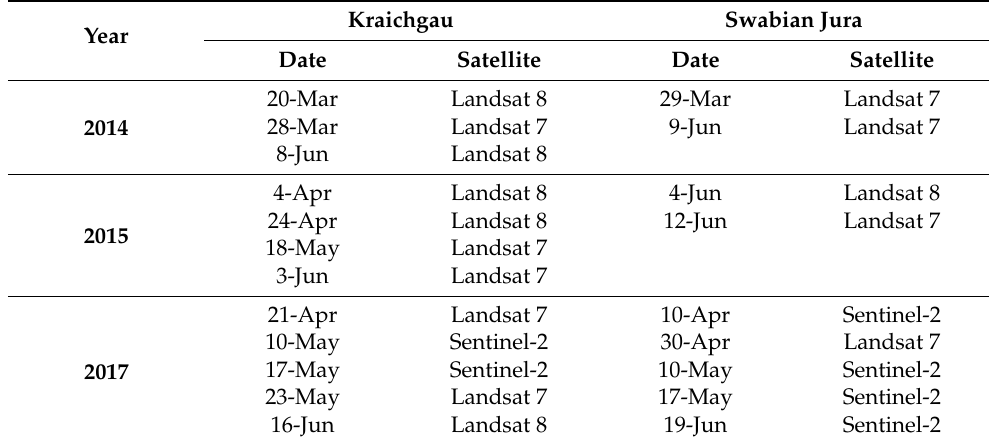
Table 2. Information on the satellite images used for data assimilation in the study. Cloud-free images from mid-March to the end of June (wheat anthesis) were